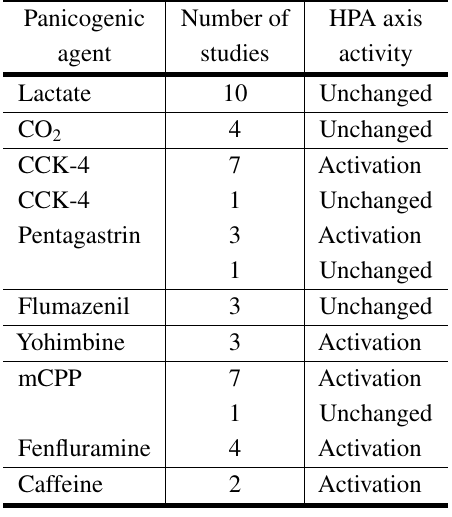
Action of panicogenic agents on the hypothalamic- pituitary-adrenal (HPA)